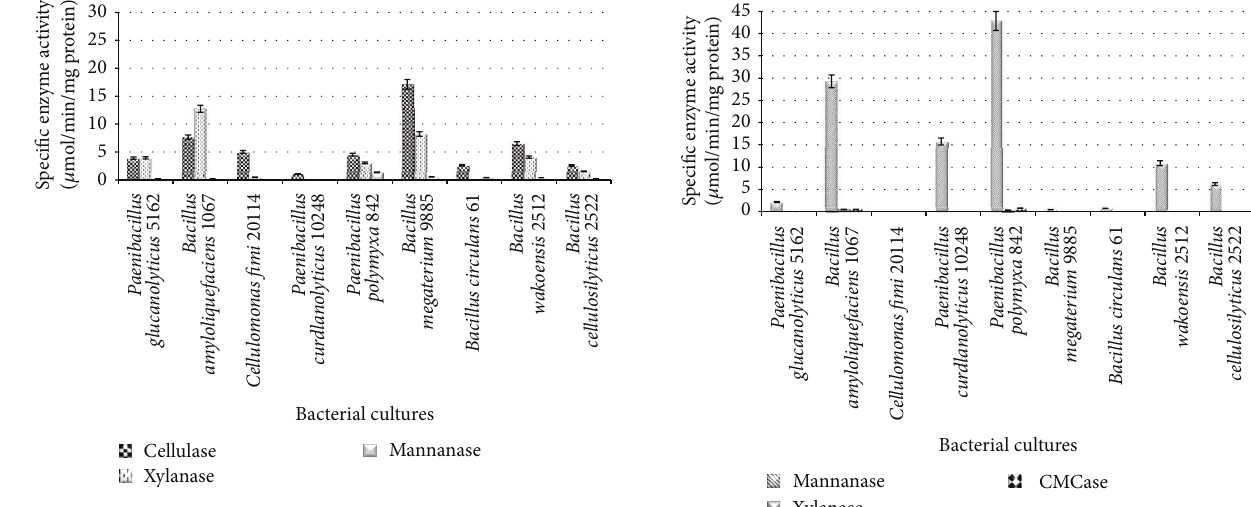
Figure 1: Specific CMCase, xylanase, and mannanase activities of cellulolytic bacteria grown in CMC medium.